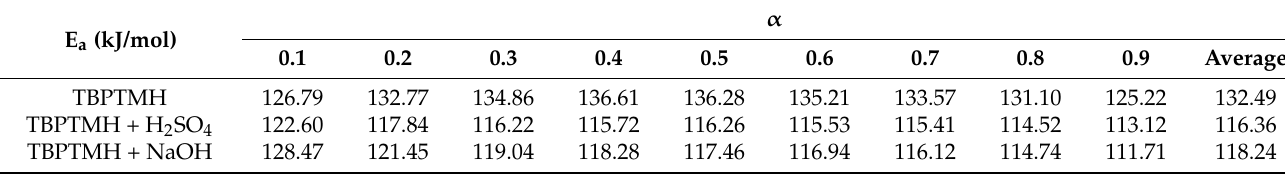
Table 5. Calculation results by Starink